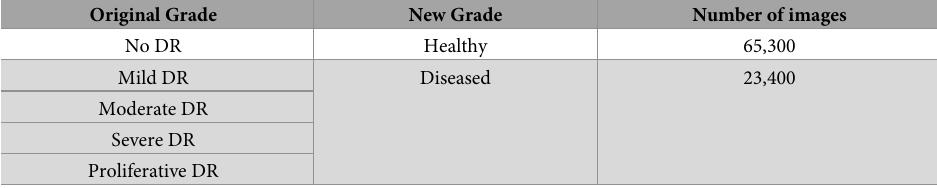
Table 2. Re-categorization of the original Kaggle EyePACS grading scheme (5 grades) to two new categories. Original